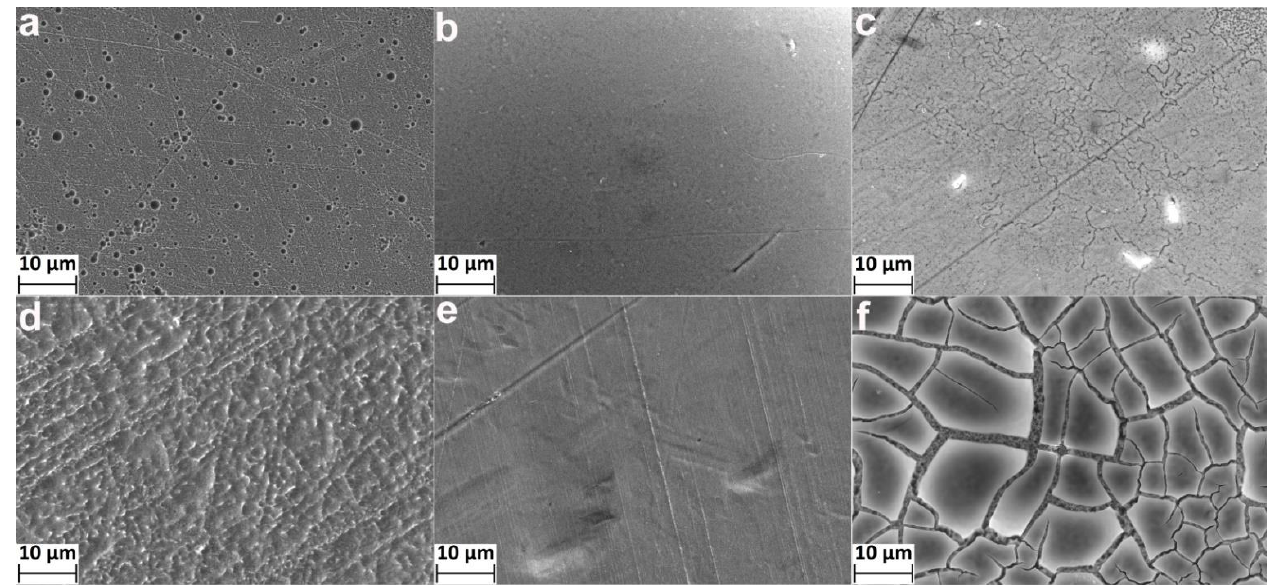
Figure 1. SEM images (10 µm scale bars) of nitinol surface for samples: ( a ) HCl/H 2 SO 4 -30 min, ( b ) H 2 SO 4 /H 2 O 2 -30 min, ( c ) NH 4 OH/H 2 O 2 -30 min, ( d ) HCl/H 2 SO 4 -120 min, ( e ) H 2 SO 4 /H 2 O 2 -120 min, ( f ) NH 4 OH/H 2 O 2 -120 min.